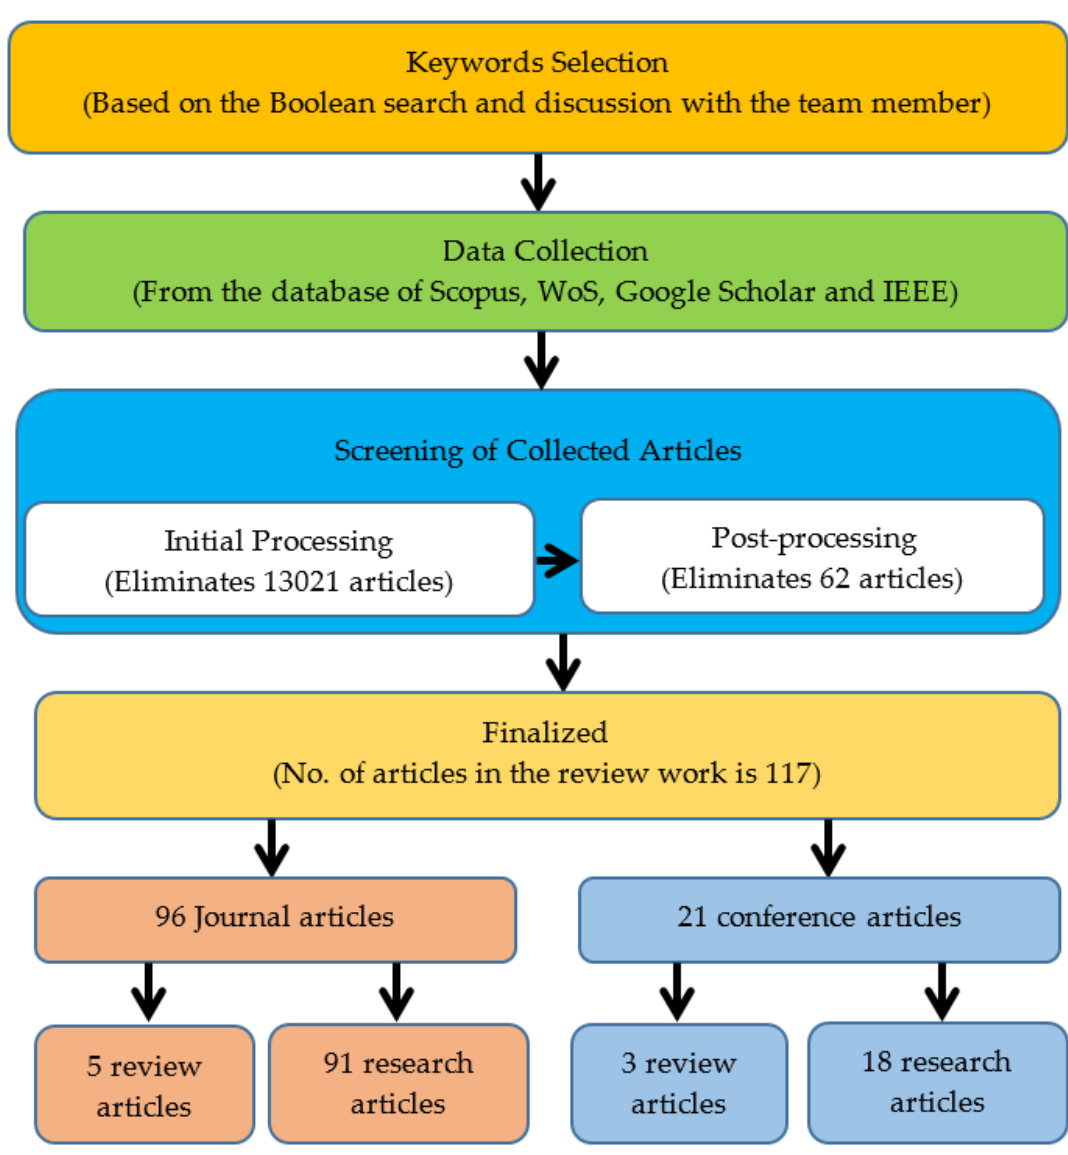
Figure 2. Representation of the data collecting process for conducting the review work.